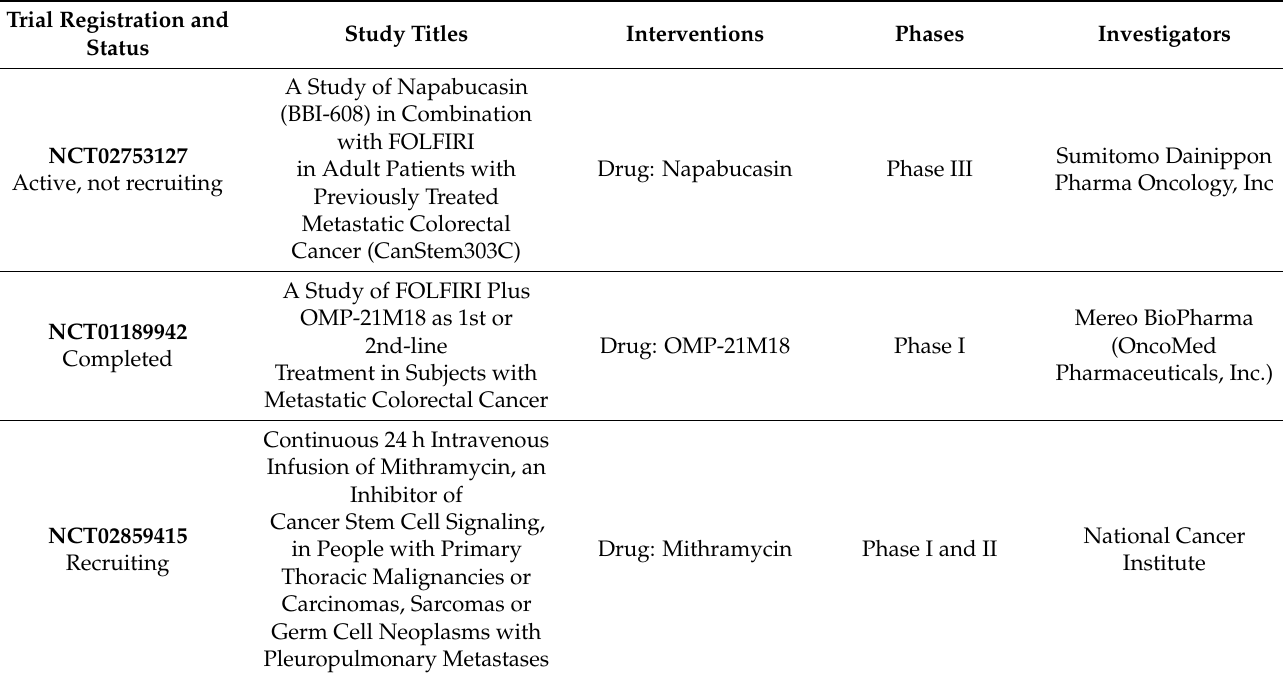
Table 5. Clinical trials on colorectal cancer and cancer stem cells from